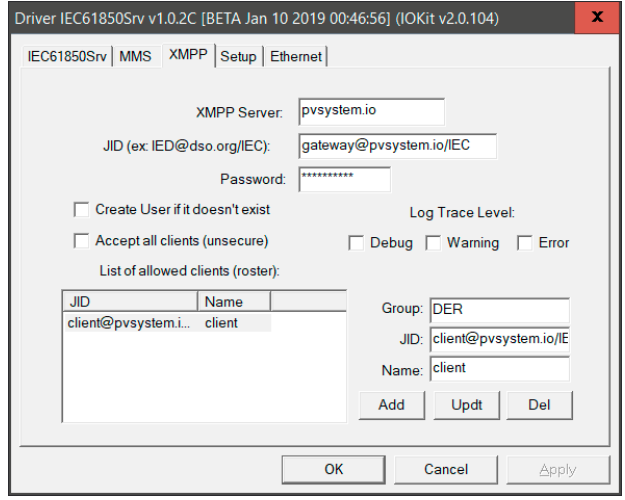
Figure 15. IEC 61850-8-2 / XMPP server driver settings.